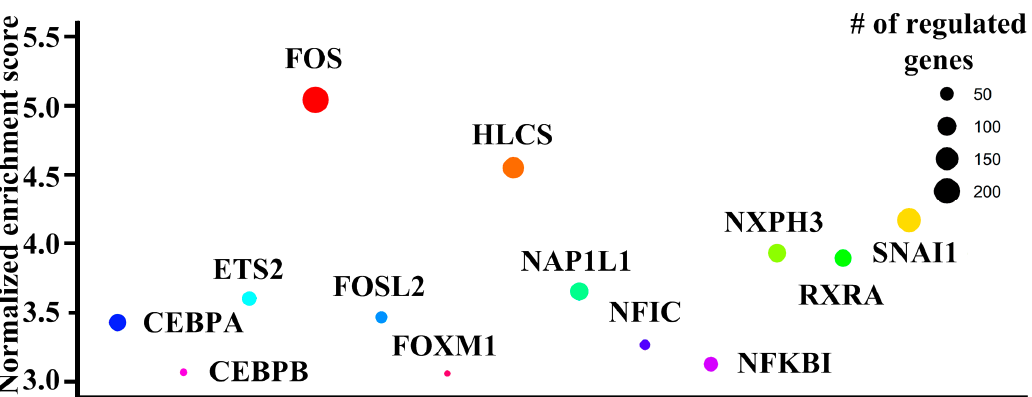
Figure 3. Transcription factors identified through iRegulon analysis. The bubble chart showed the transcription factors associated with differentially methylated and differentially expressed genes identified by iRegulon. Y-axis label represented normalized enrichment score. The sizes of the bubbles were proportional to the number of regulated genes with concomitant differential methylation and differential expression for each transcription factor.